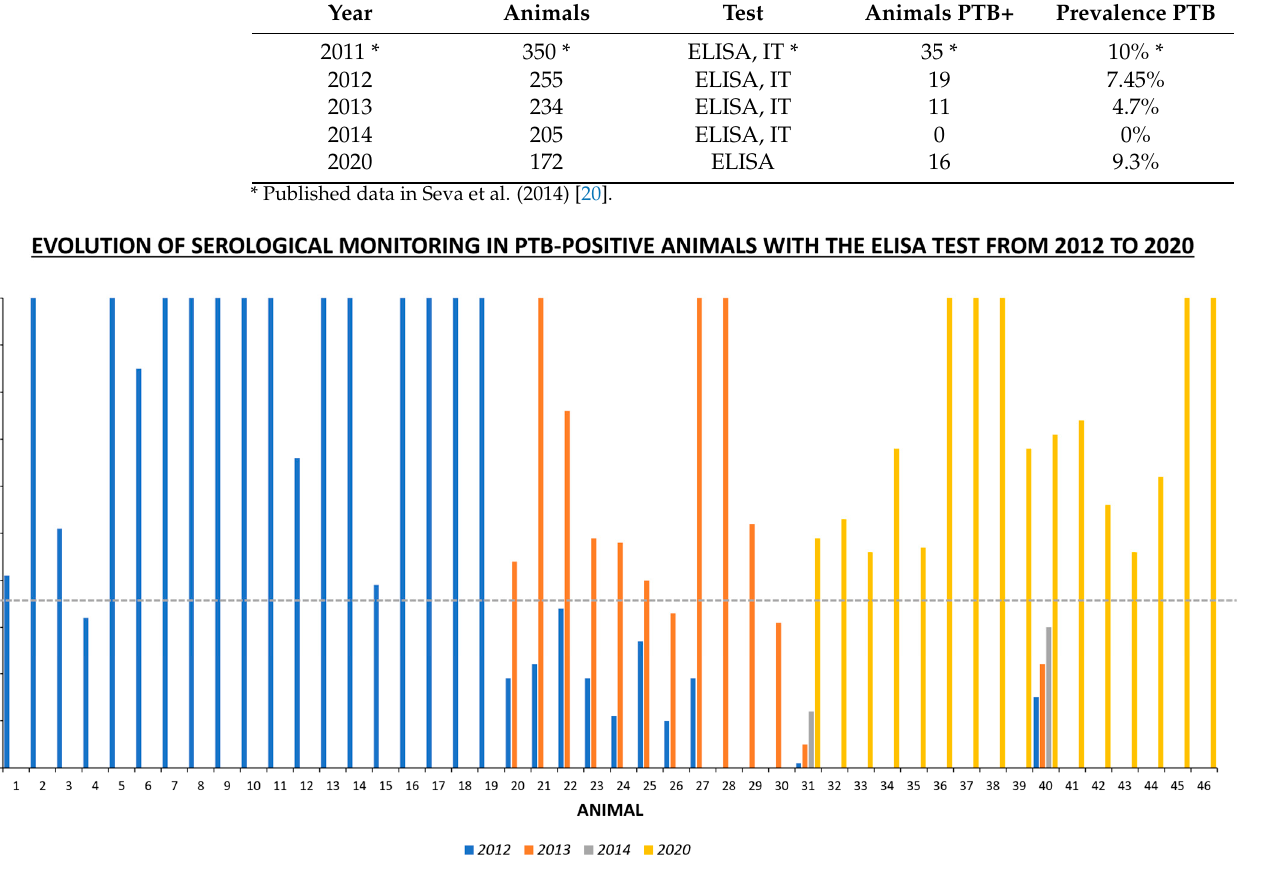
Table 2. Positivity against MAP in PCR samples of intestine, feces, and foot skin of pigeons. Animal